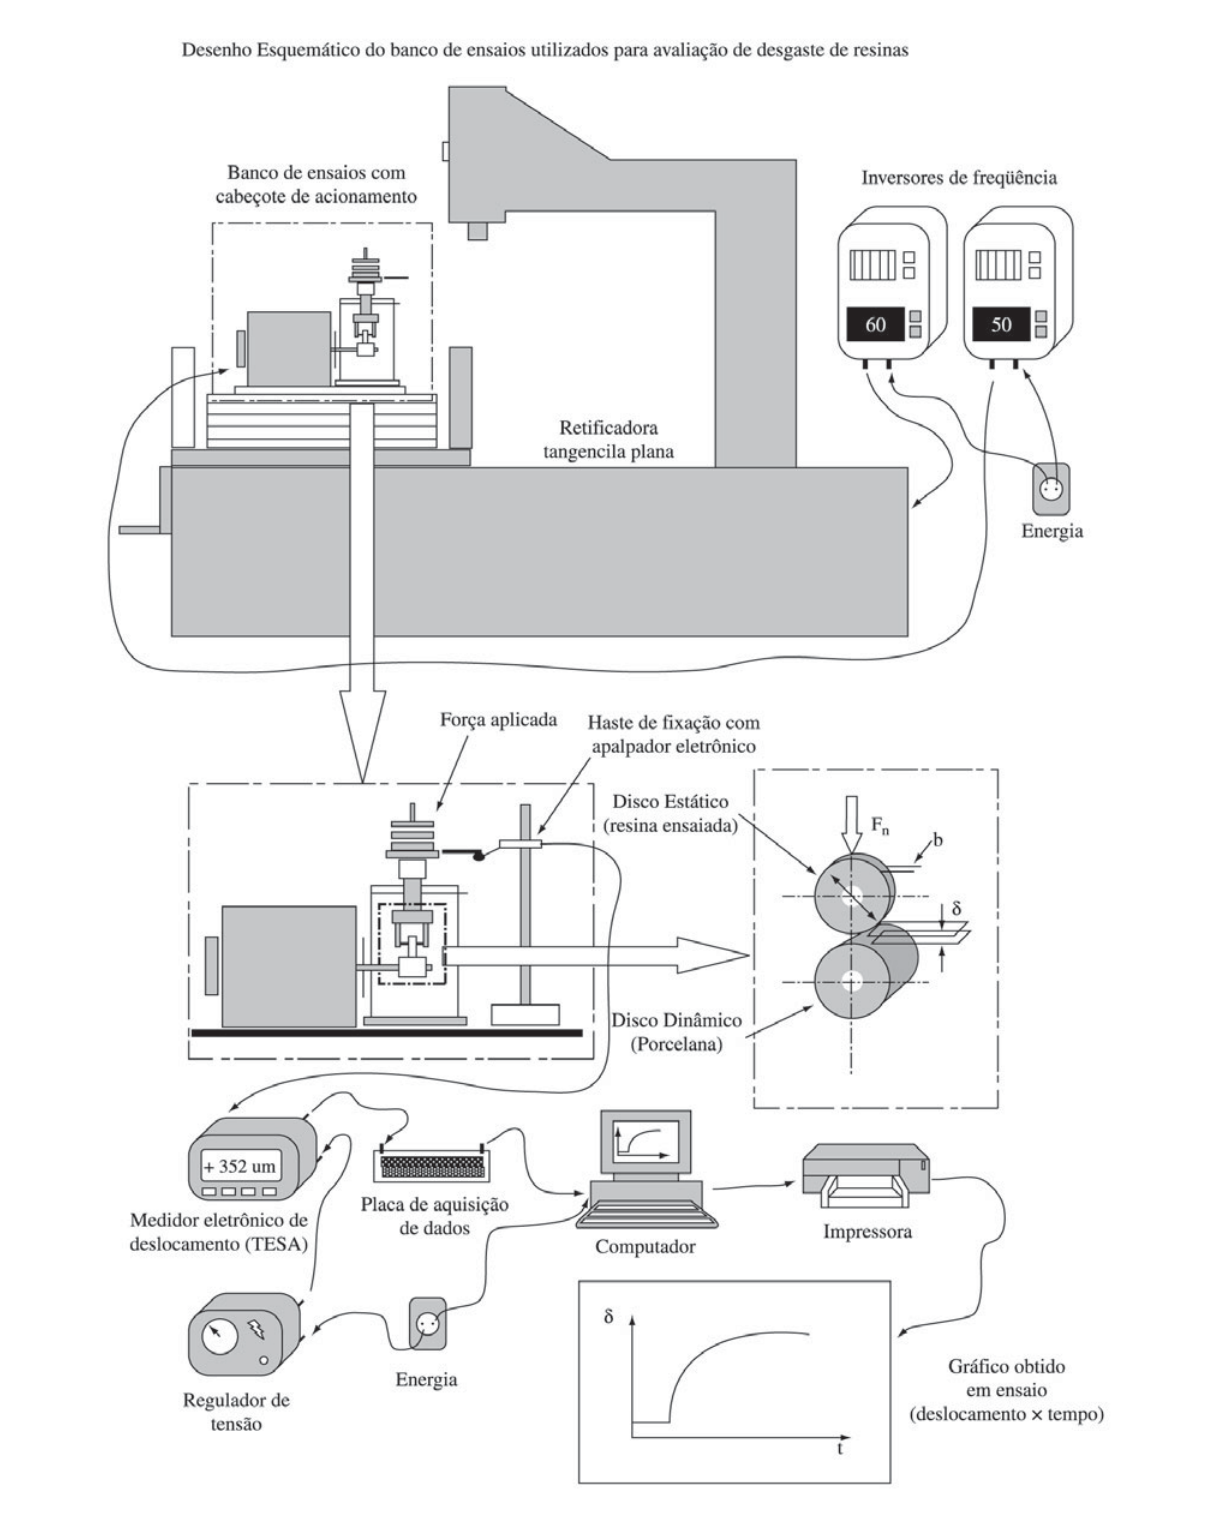
Figura 6. Resumo Esquemático da Metodologia utilizada nos